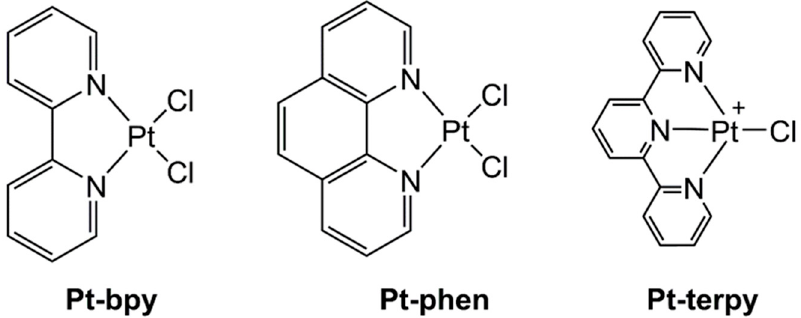
Figure 1. Structure of the Pt(II) complexes investigated in the present work (bpy = 2,2 (cid:48) -bipyridine, phen = 1,10-phenanthroline, terpy = 2,2 (cid:48) :6 (cid:48) ,2 (cid:48)(cid:48) -terpyridine).